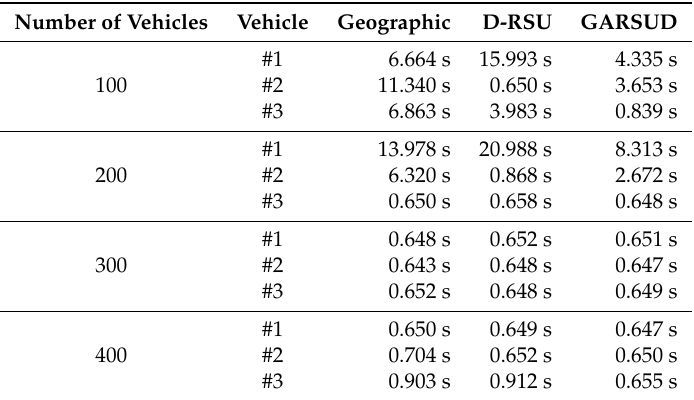
Table 5. Warning notification time (in seconds) for each warning vehicle when deploying 4 RSUs in Madrid considering a uniform traffic flow.